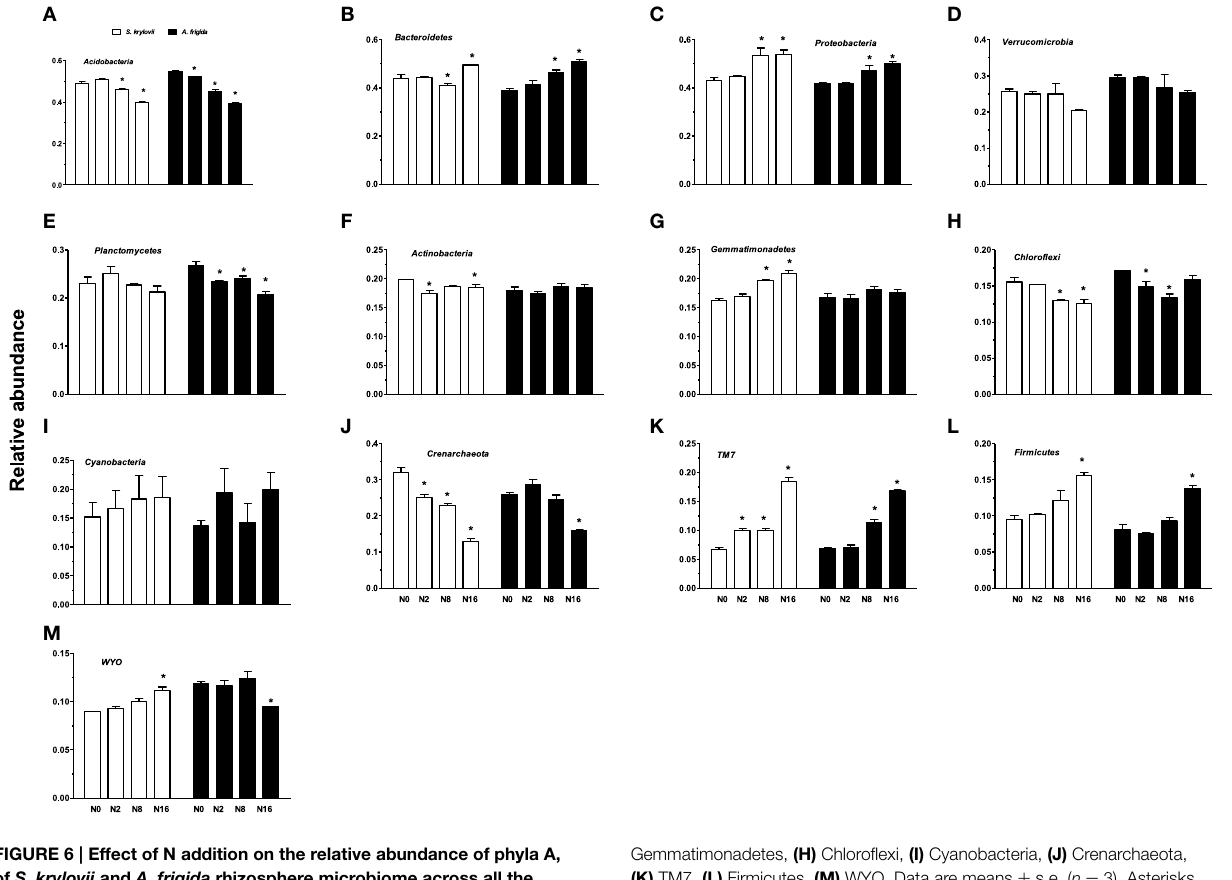
Gemmatimonadetes, (H) Chloroflexi, (I) Cyanobacteria, (J) Crenarchaeota, (K) TM7, (L) Firmicutes, (M) WYO. Data are means ± s.e. ( n = 3 ). Asterisks on the top of columns indicate significant difference at P < 0.05 between N0 and different rates of N addition for each